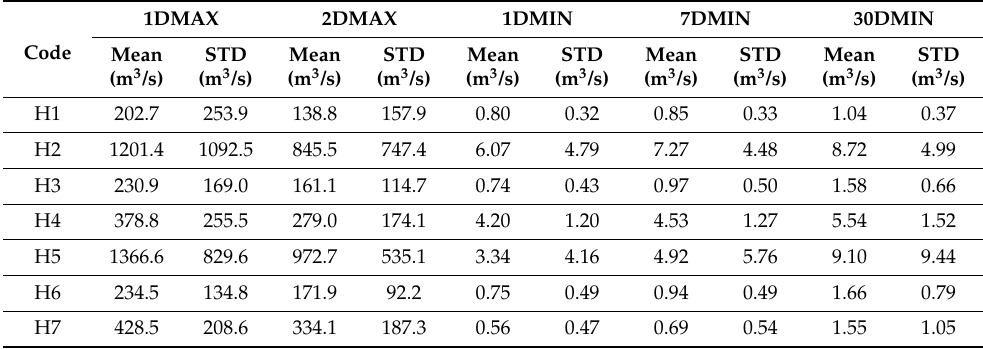
Table 4. Annual mean and standard deviation of the maximum and minimum flow indices for the